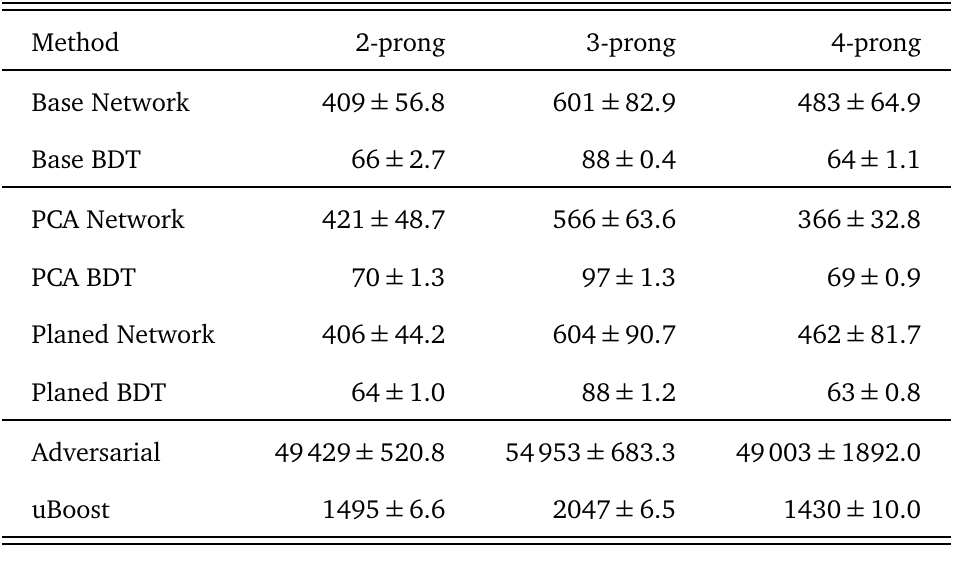
Table 2: The time in seconds to train a classifier on dual E5-2690v4 (28 core) proces- sors. The mean and standard deviation are calculated over 10 independent